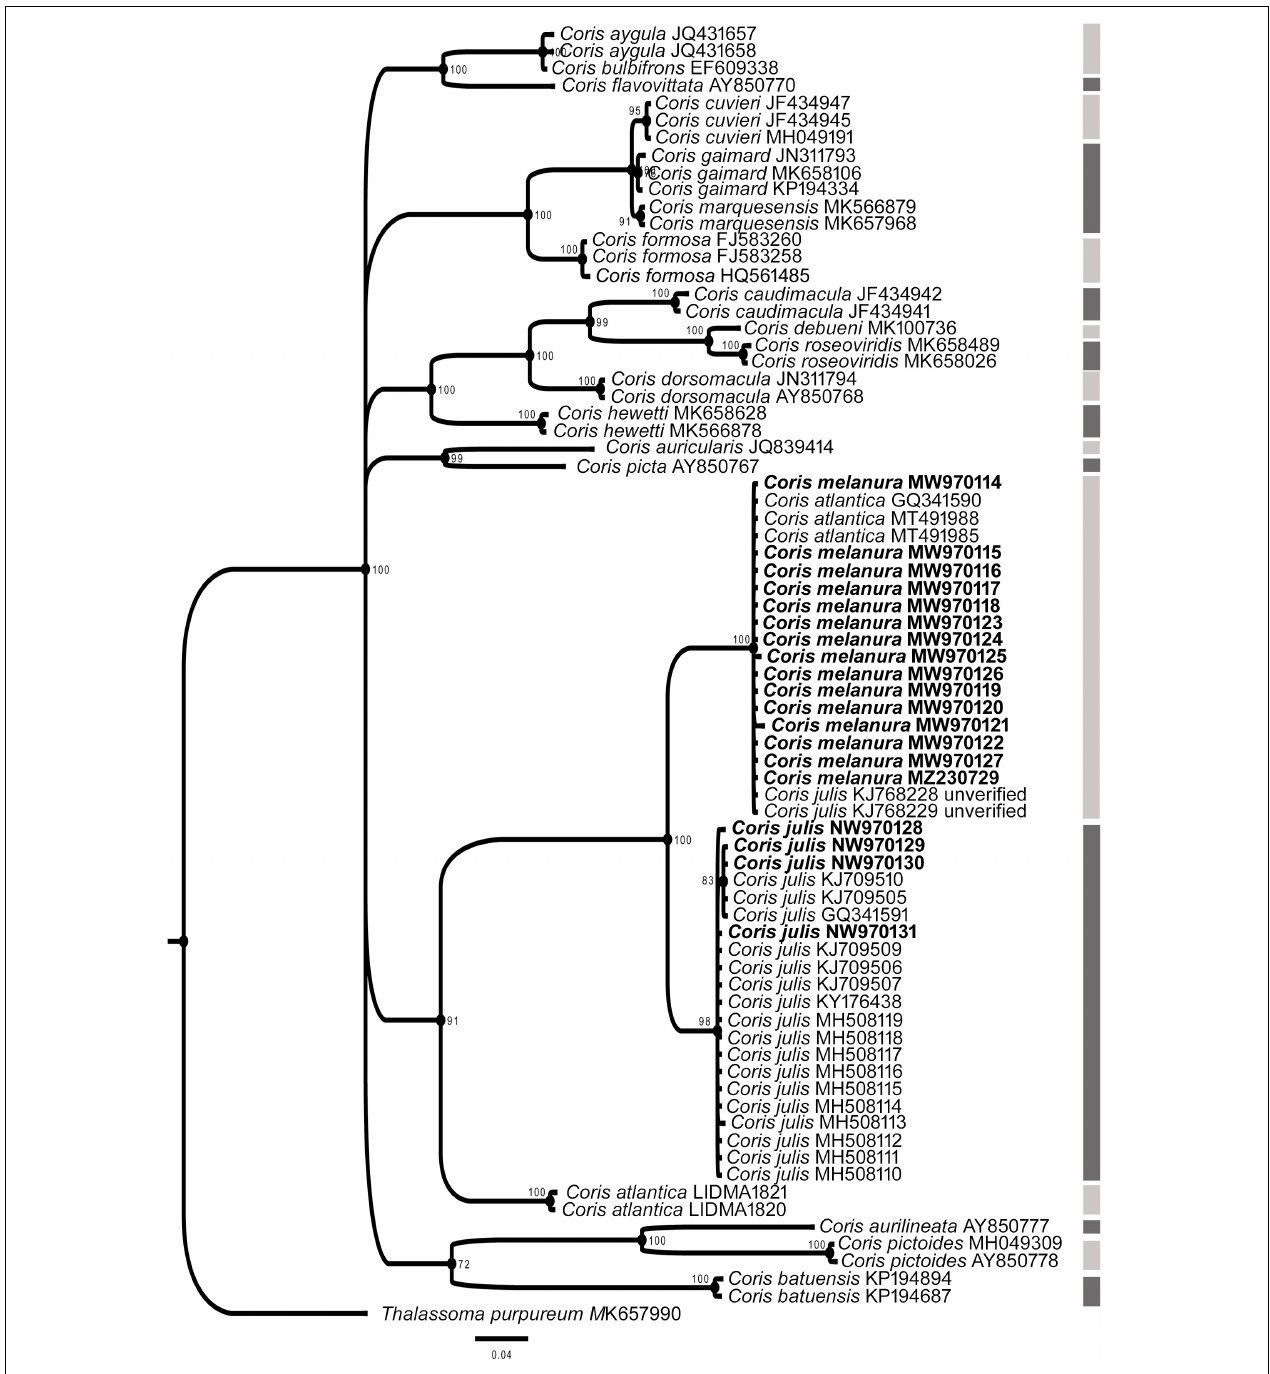
FIGURE 7 | Phylogenetic relationship based on Bayesian Inference (BI) for COI fragment for Coris species. Posterior probabilities (%) and GenBank and BOLD Systems accession numbers are indicated near the nodes and the species name, respectively. Species delimitation analysis using Poisson Tree Process (bPTP) is indicated by lateral dark and light gray side bars. The samples analyzed here are indicated in